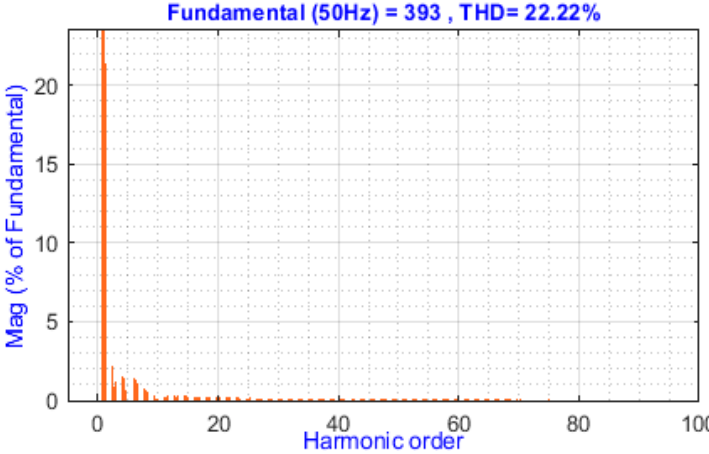
Figure 14. Total and individual harmonics levels of the output current at PCC.